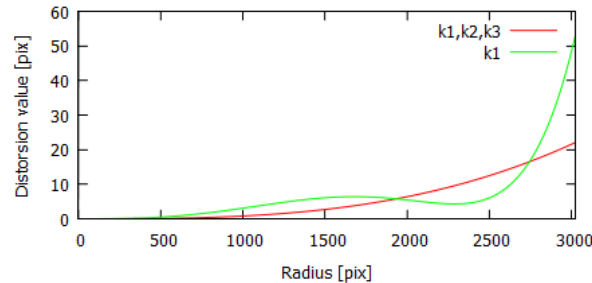
Figure 6. Comparison of distortion values for both methods of calculation. Red – single image calibration (parameters k1, k2, k3 of radial distortion); Green – single image calibration (parameters k1 of radial